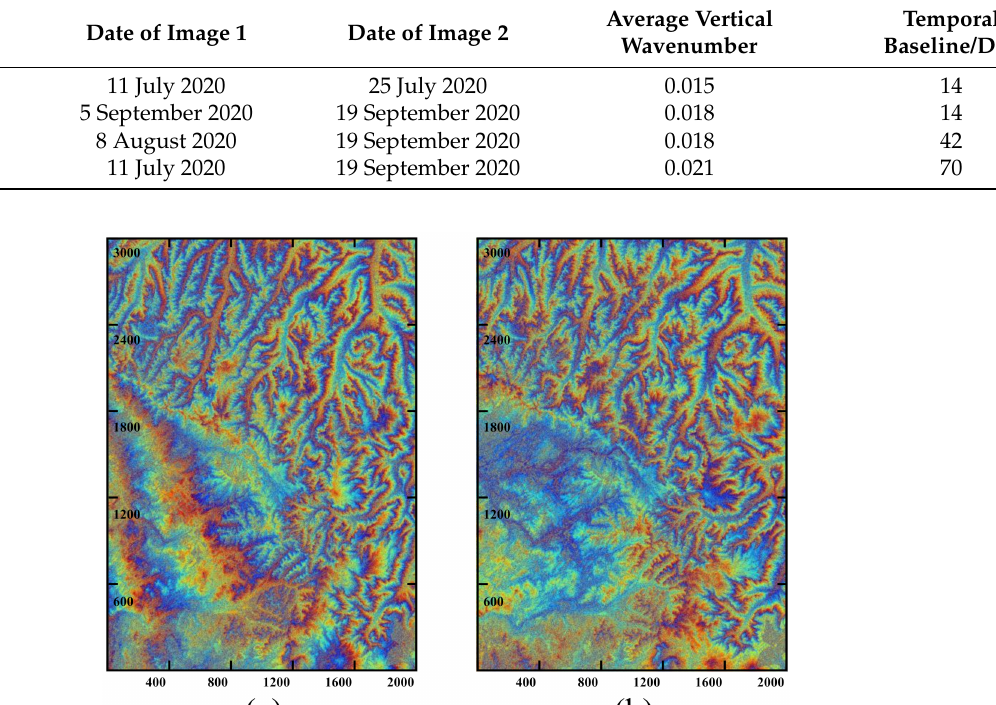
Figure 4. ( a ) Grayscale image of the original L-band image under HV polarization; ( b ) PolInSAR image Pauli-based false color image; ( c ) interferometric DEM of the on-board data. Table 2. PolInSAR interferometric datasets.